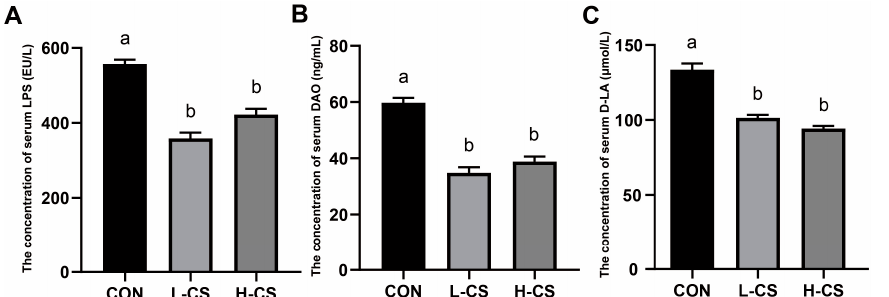
Figure 2. The effects of chitosan on functional parameters in the serum intestinal barrier: ( A ) Lipopolysaccharide (LPS); ( B ) Diamine oxidase (DAO); ( C ) D-lactate (D-LA). Note: CON represents basic diet; L-CS, basic diet containing 500 mg/kg chitosan; H-CS, basic diet containing 2000 mg/kg chitosan; and SEM, standard error of means. Values are presented as means ± SEMs, n = 10. Different letters on the top of the column represent significant differences ( p < 0.05).